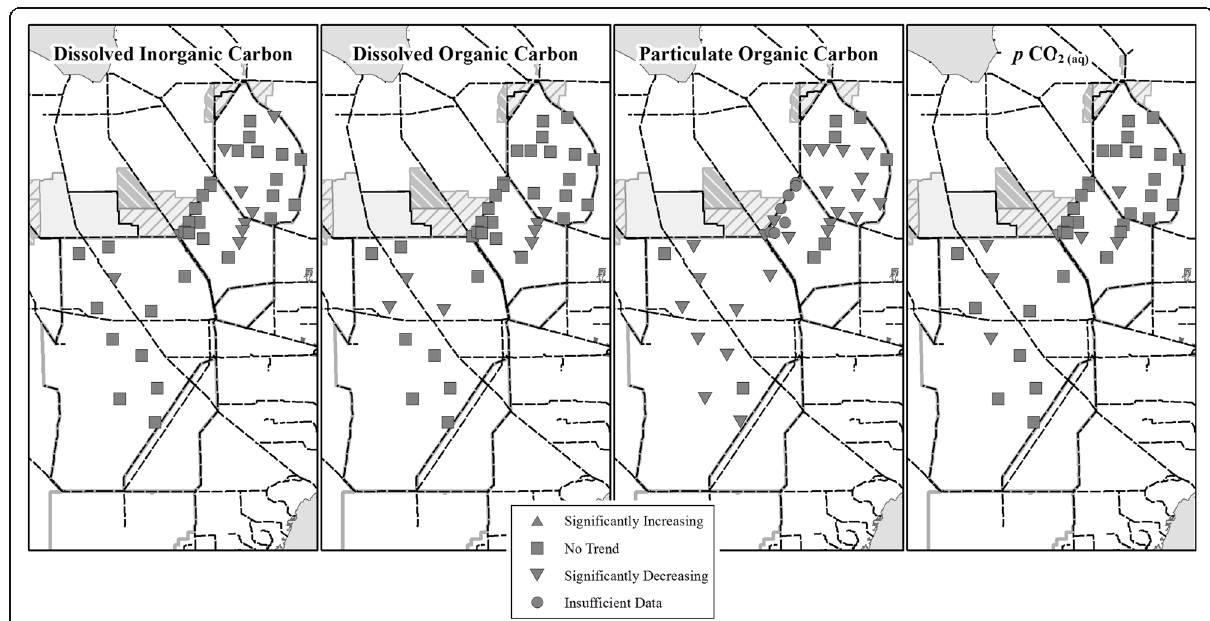
Fig. 2 Annual Kendall trend analysis results for each monitoring location with enough data (greater than six samples per year and three water years) for dissolved inorganic carbon, dissolved organic carbon, particulate organic carbon, and surface water pCO 2 (pCO 2(aq) ). Significantly increasing or decreasing trends were determined based on a ρ value<0.05 and positive or negative Kendall τ values to denote direction. No trend results were identified as ρ values>0.05